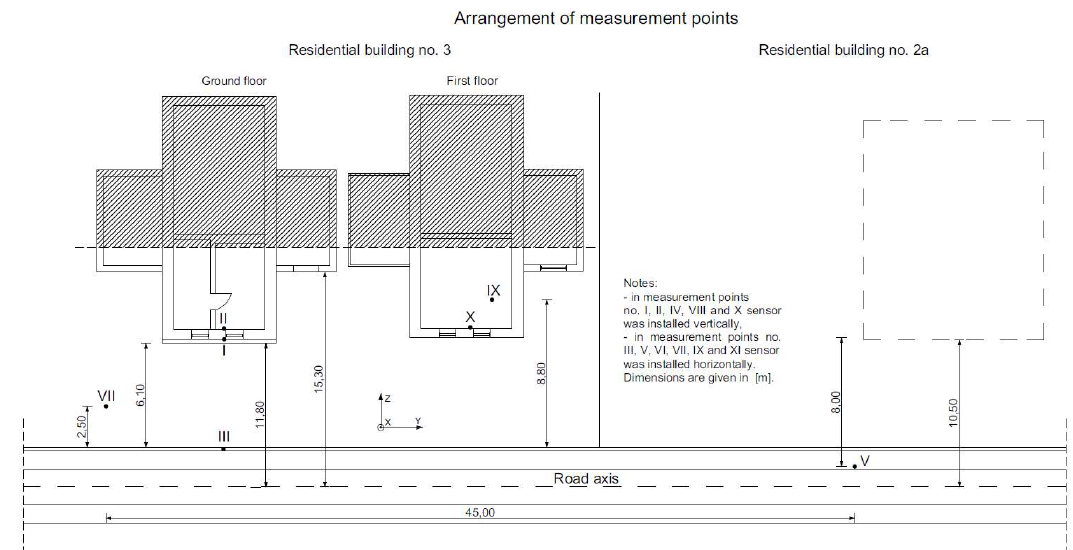
Figure 5. Arrangement of measuring points.